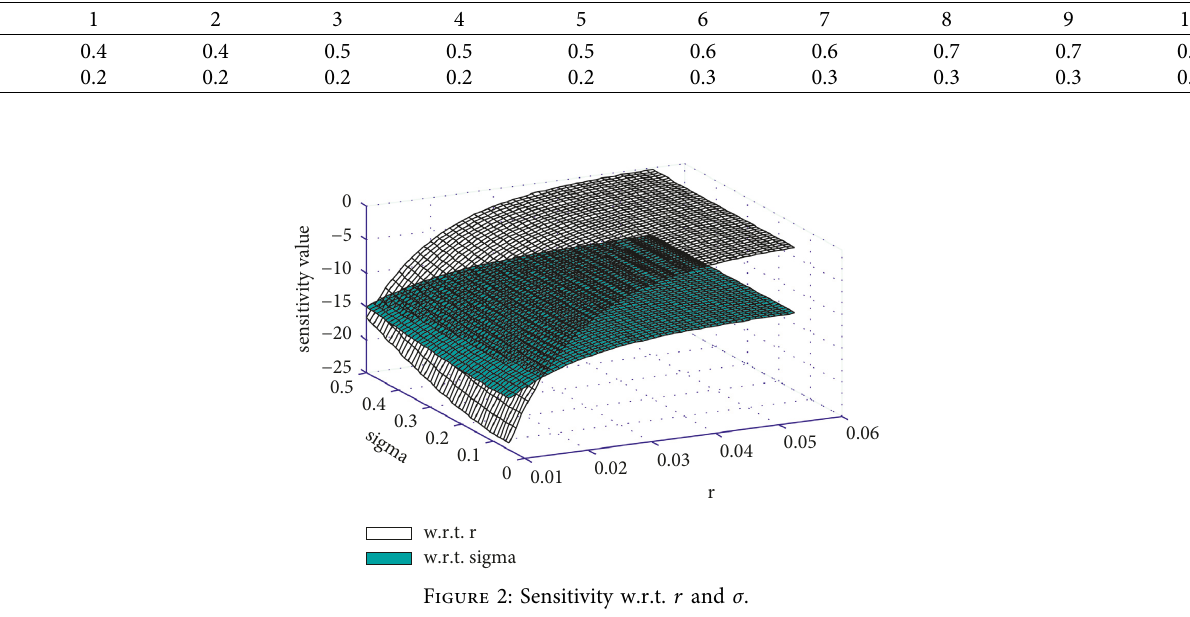
Table 1: Values of a